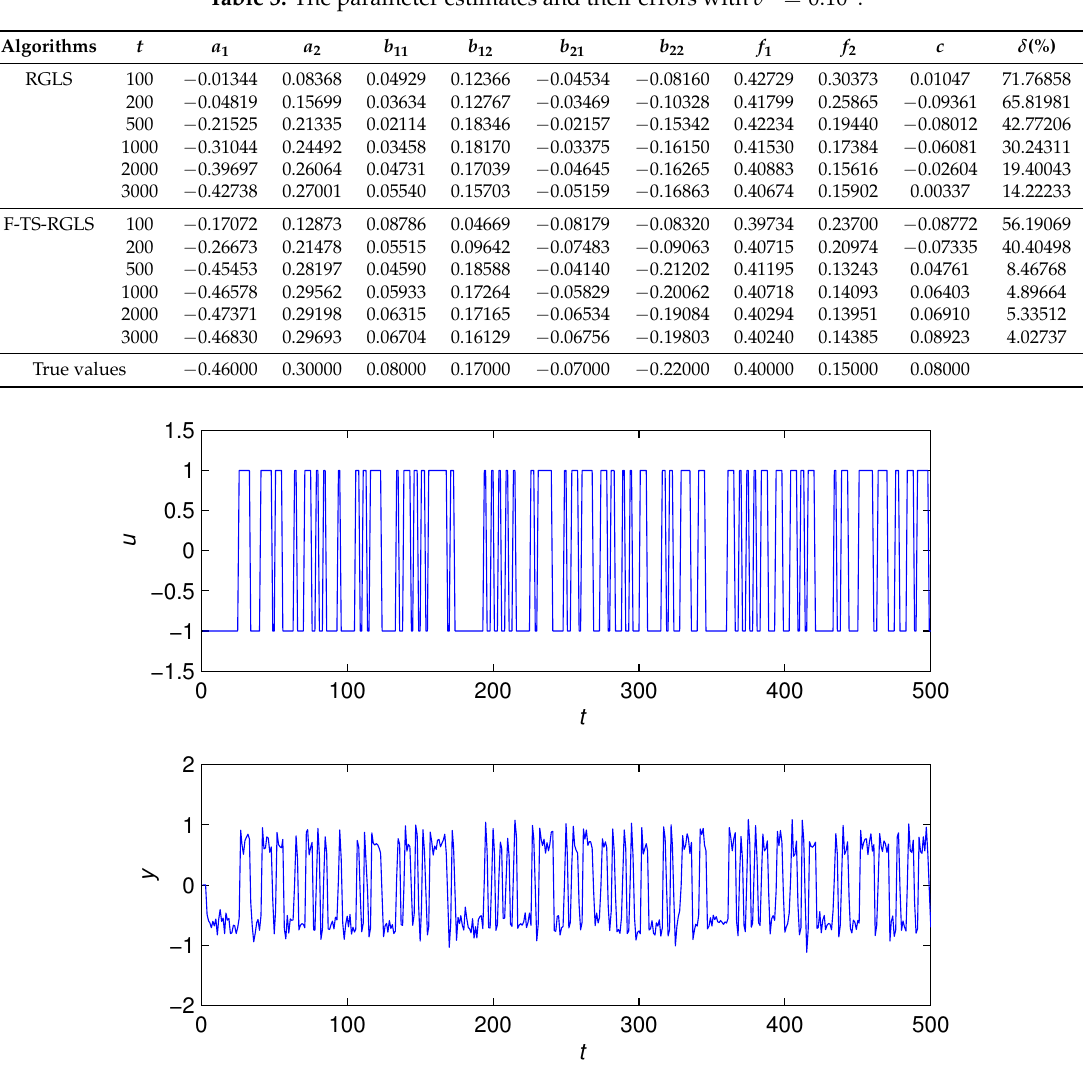
Figure 1. The simulated input-output data versus t